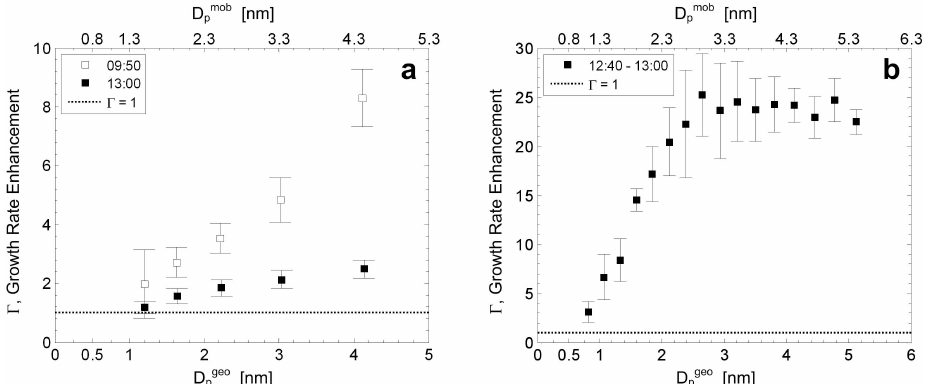
Fig. 2. Values of the growth rate enhancement 0 and their corresponding uncertainties are plotted as a function of particle mobility diameter D mob p (upper abscissa) and particle geometric diameter D geo p (lower abscissa) for the NPF event observed on (a) 7 August 2009 (NCCN), where uncertainties are presented as one standard deviation, and on (b) 19 September 2010 (NCAR) where uncertainties are presented as one standard error, calculated according to Cantrell (2008). A dotted line indicating 0 = 1 is shown for reference. Geometric particle diameters were estimated according to Larriba et al.